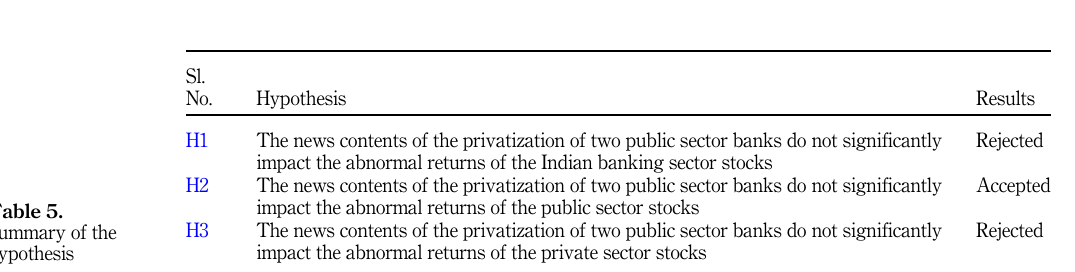
Table 4. Average and cumulative average abnormal returns and corresponding t -values for public sector banks ( N 5 12) and private sector banks ( N 5 10) in the shorter event windows